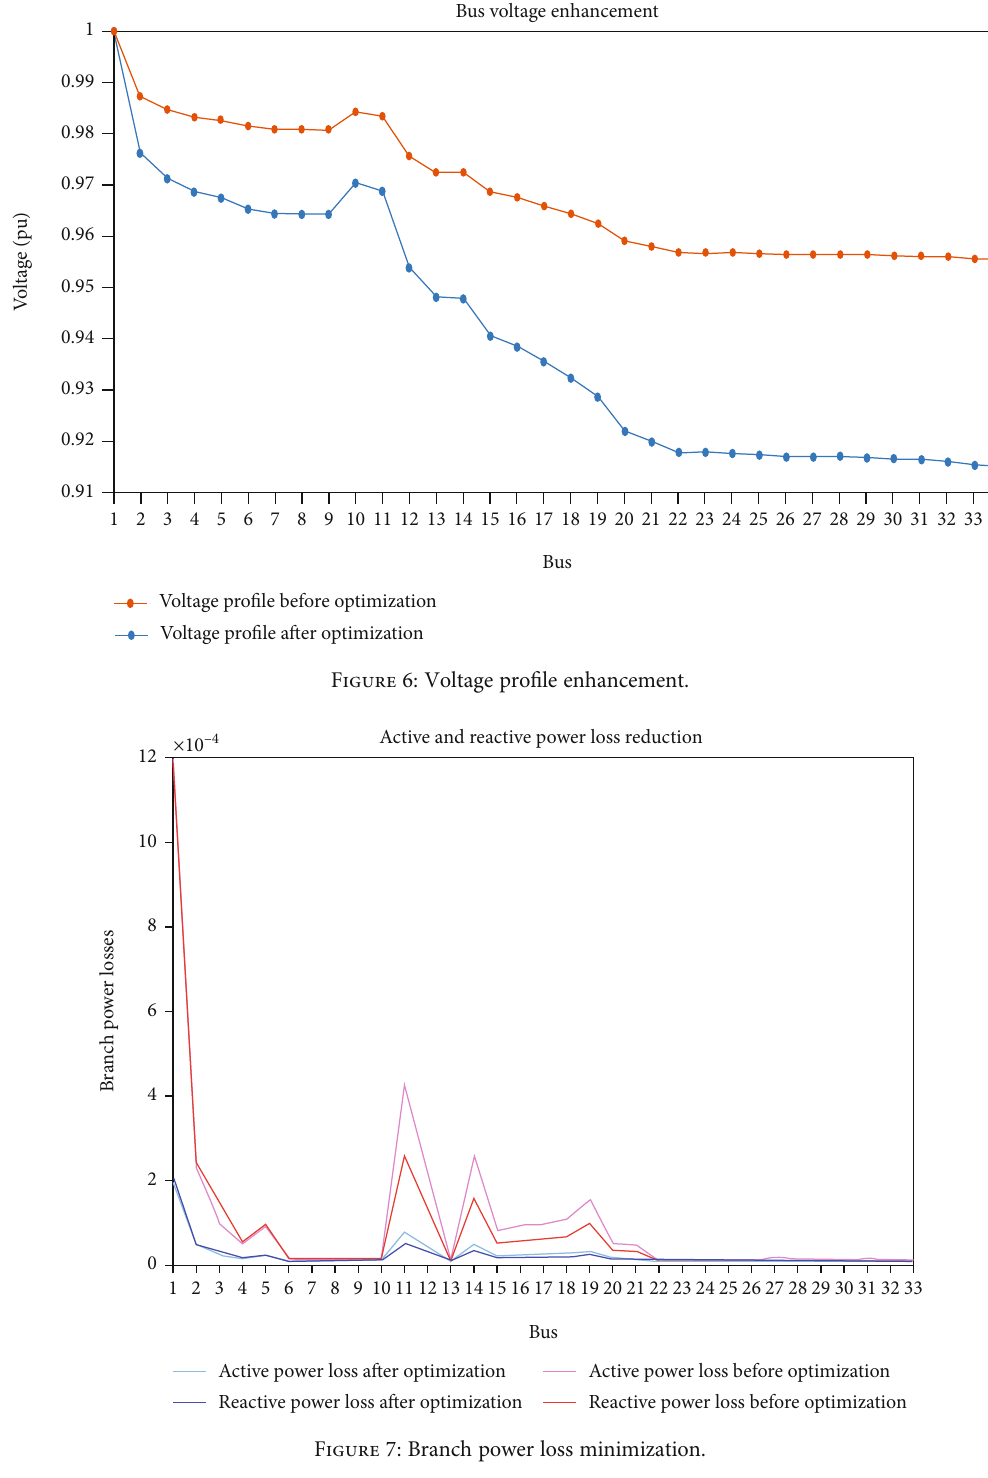
Figure 7: Branch power loss